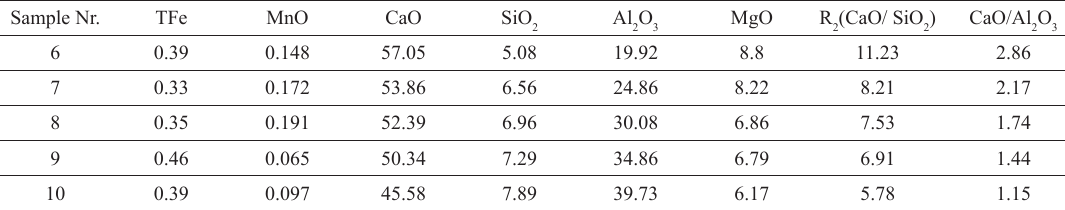
Table 2. The chemical compositions of slag samples of LF end (mass%). Sample